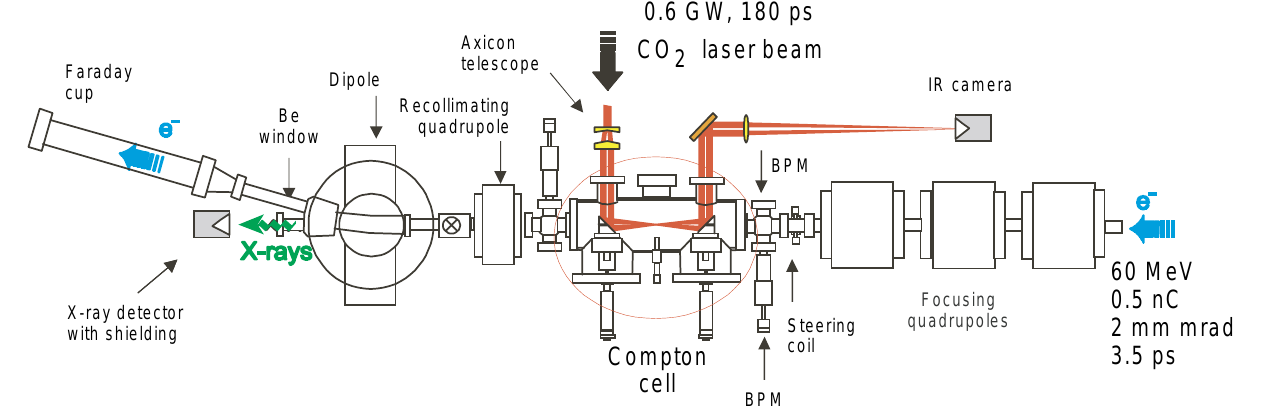
FIG. 1. (Color) Principle diagram of the CO 2 LSS experiment.